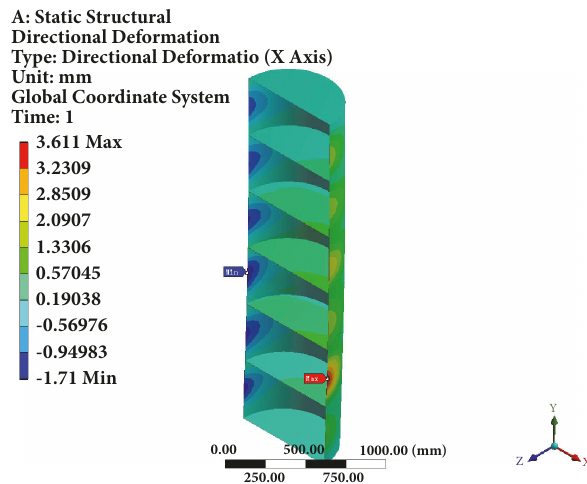
Figure 8: Displacement variation contour of drag rotor.